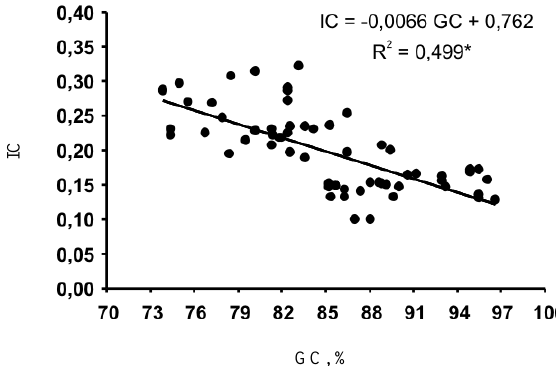
Figura 4. Relação entre o índice de compressão (IC) e o grau de compactação do solo